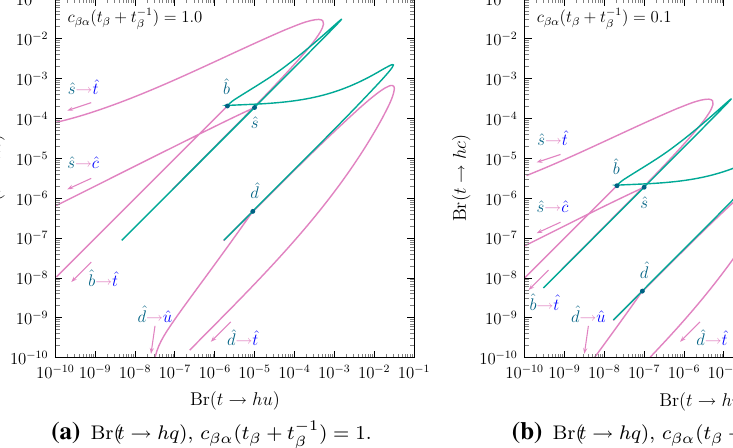
Fig. 5 Br ( t → hc ) vs. Br ( t → hu ) FCNC processes in gBGL models